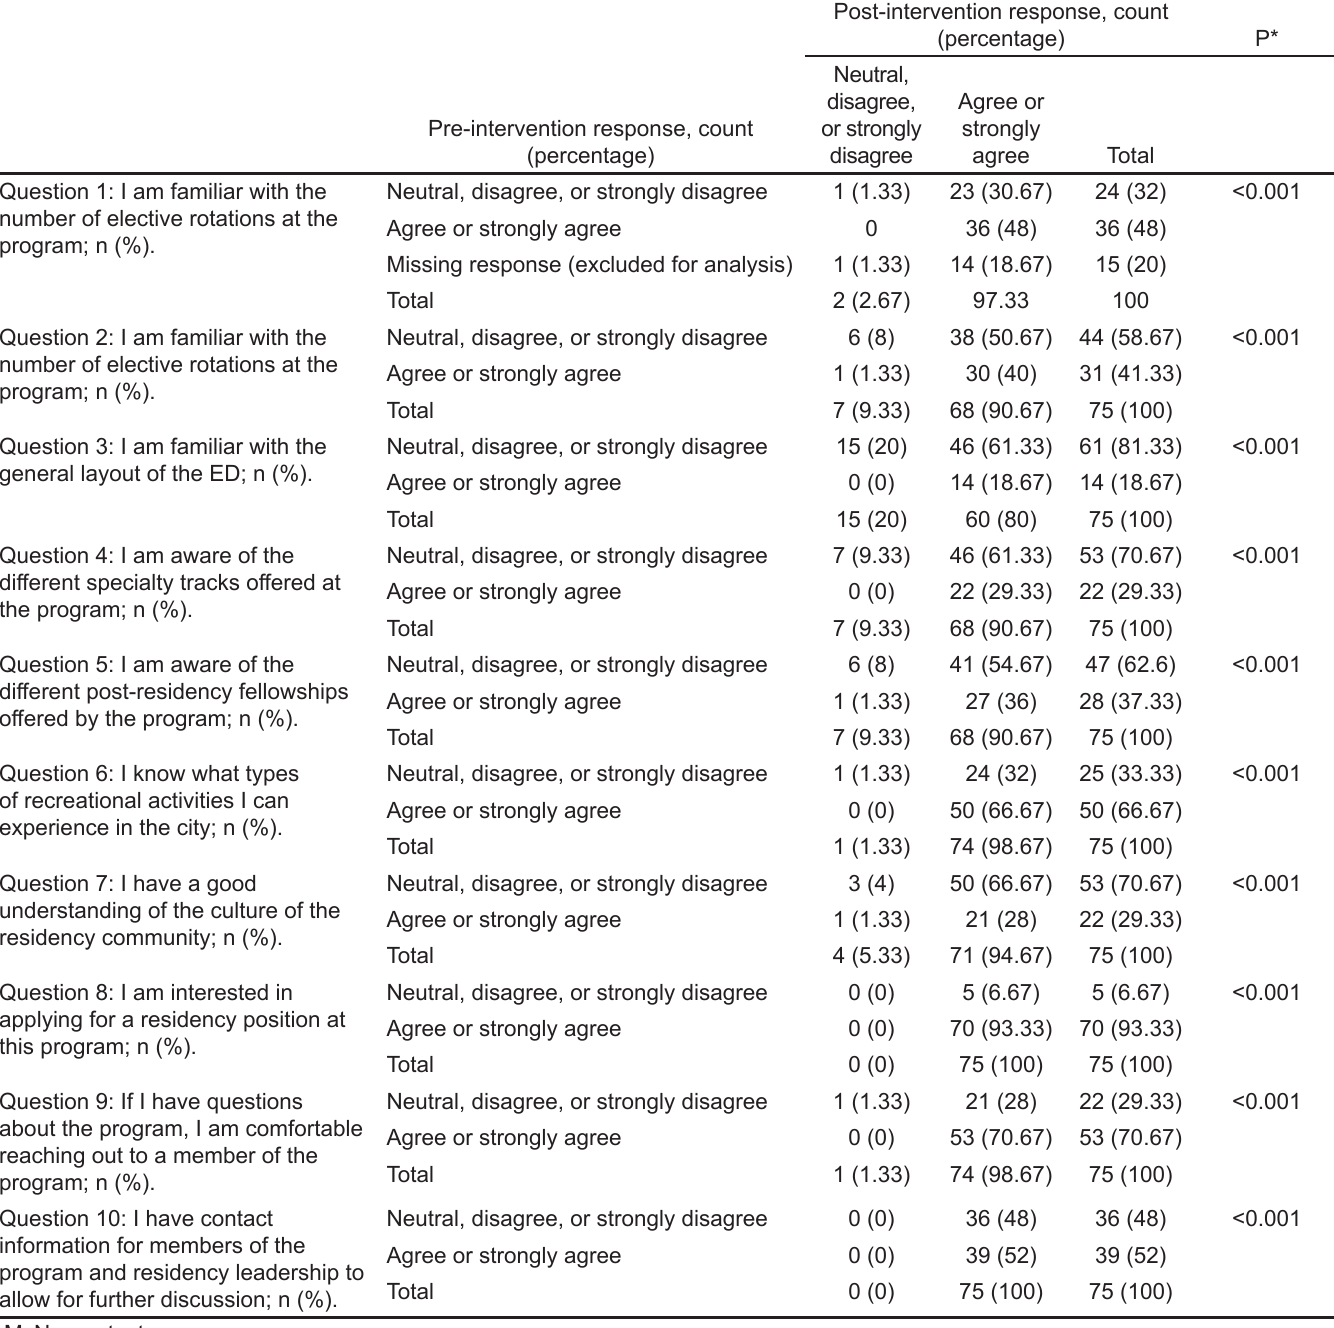
Table 5. Dichotomized levels of agreement of the respondents to the questions before and after the